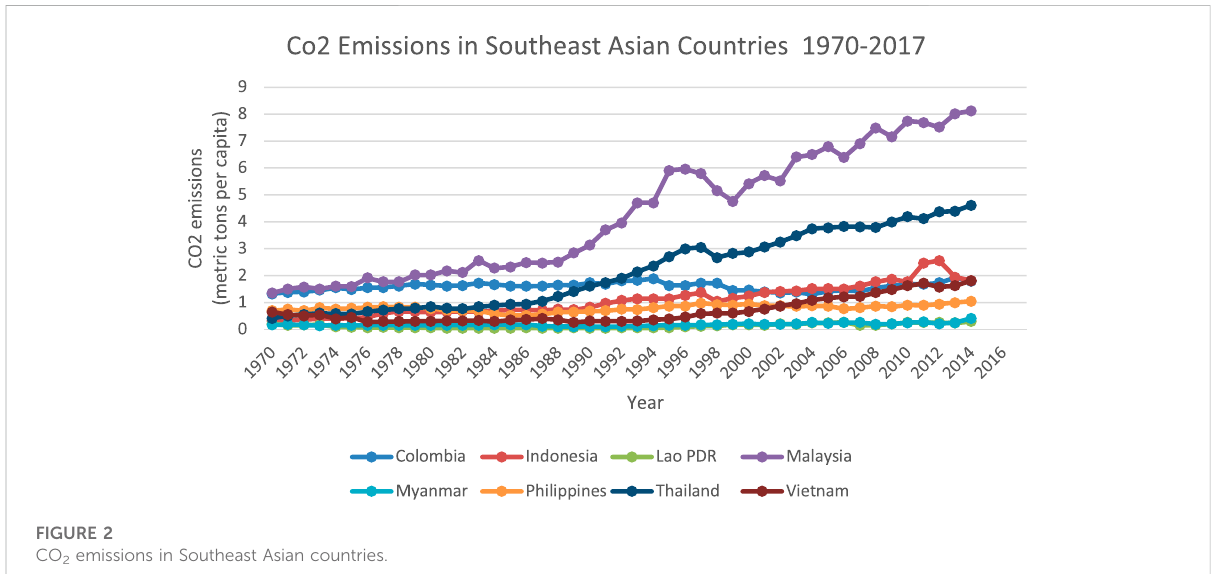
FIGURE 2 CO 2 emissions in Southeast Asian